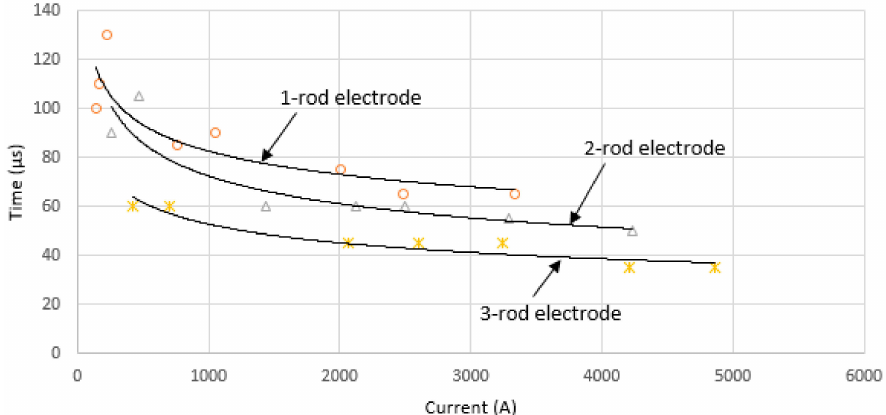
Figure 23. Time to discharge to zero for current against peak current for 1-rod, 2-rod and 3-rod electrodes installed at sites 1, 2, 3 and